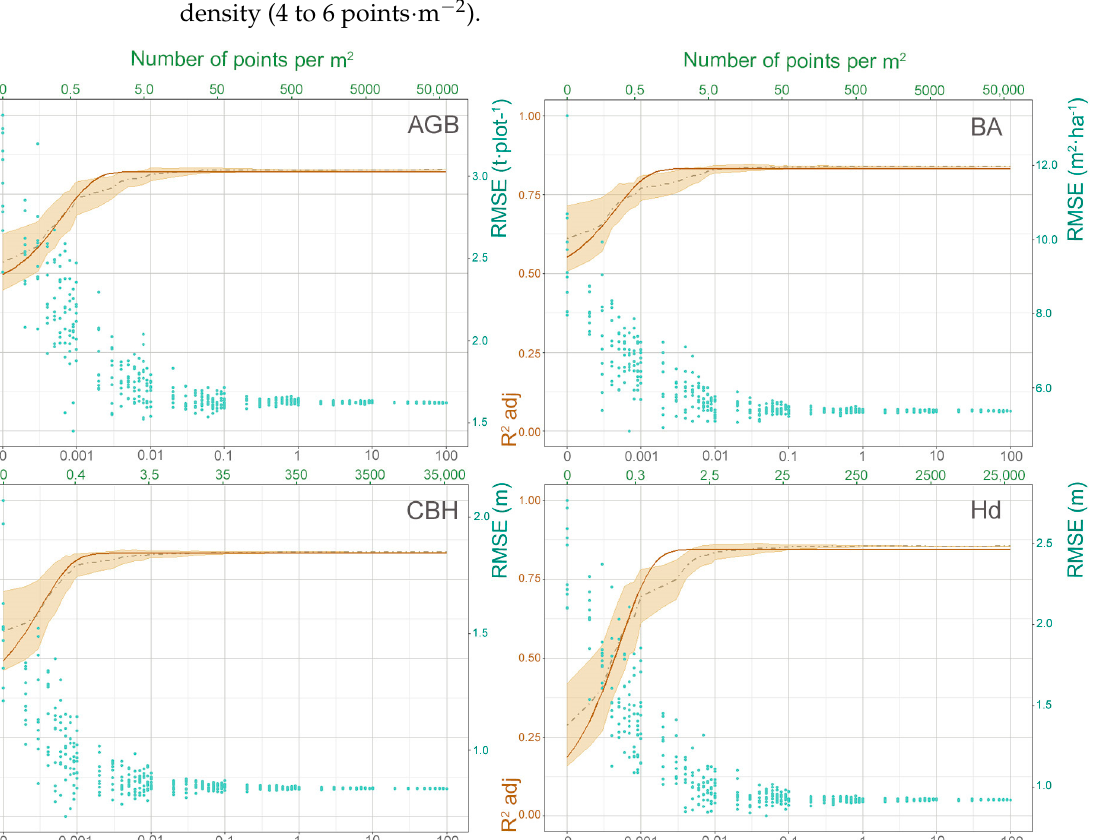
Figure 9. Variation in R 2adj and RMSE in the estimate of forest parameters AGB , BA , CBH , Hd , N , QMD , and SDI , with respect to the point density. The light brown area represents the standard deviation for the 10 test repetitions performed for each point density. The dashed gray curve repre- sents the mean value of the point distribution. The brown curve represents the fitted model (nega- tive exponential). The blue dots represent the RMSE values obtained for the 10 test repetitions per- formed for each point density.